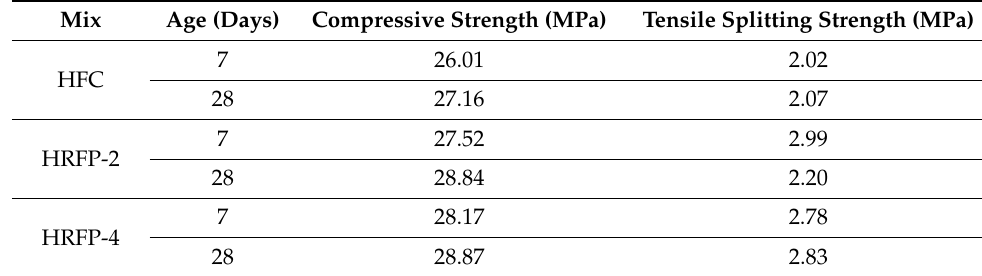
Table 6. Concrete mechanical properties.